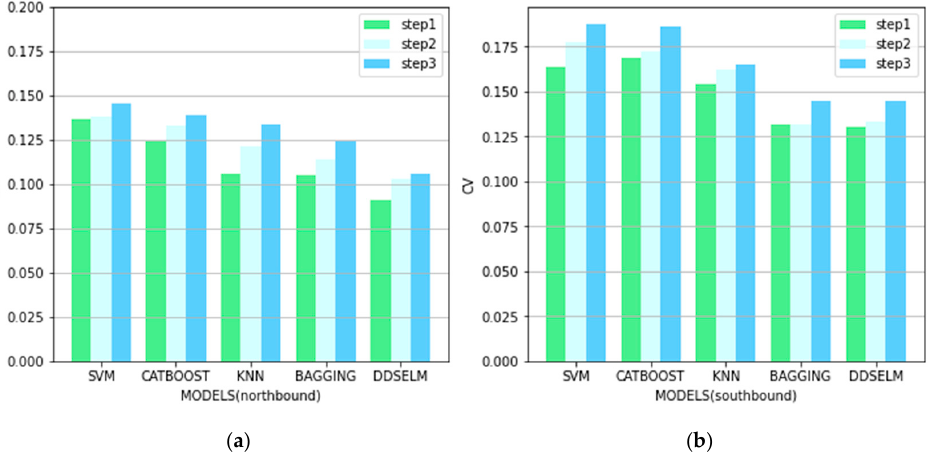
Figure 8. Performance of five predictive models’ results in CVs: ( a ) CVs of predictive results in northbound; ( b ) CVs of predictive results in southbound